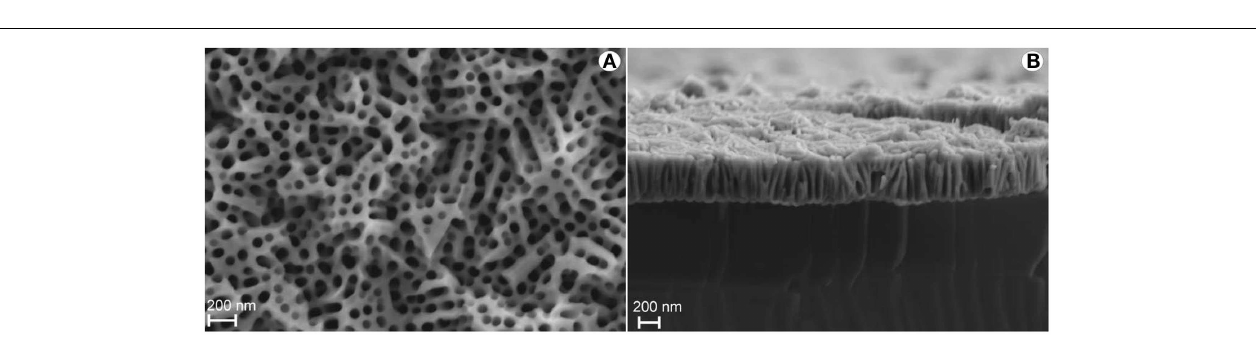
FIGURE 2 | SEM micrographs of PAAF obtained from sputteredAl-films . (A) Top view showing poor pore ordering; (B) cross-section showing poor verticality of the pores. Scale bar